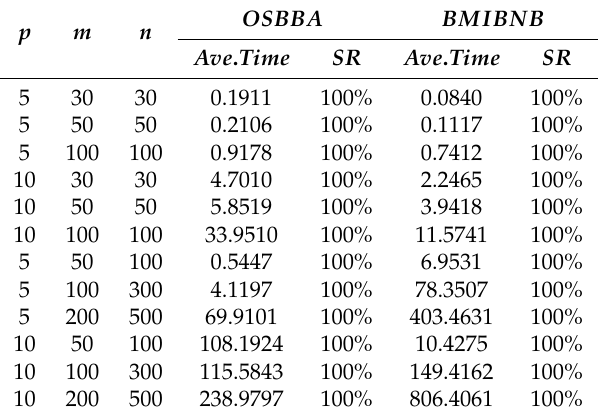
Table 4. The results of random calculations for Example 12.